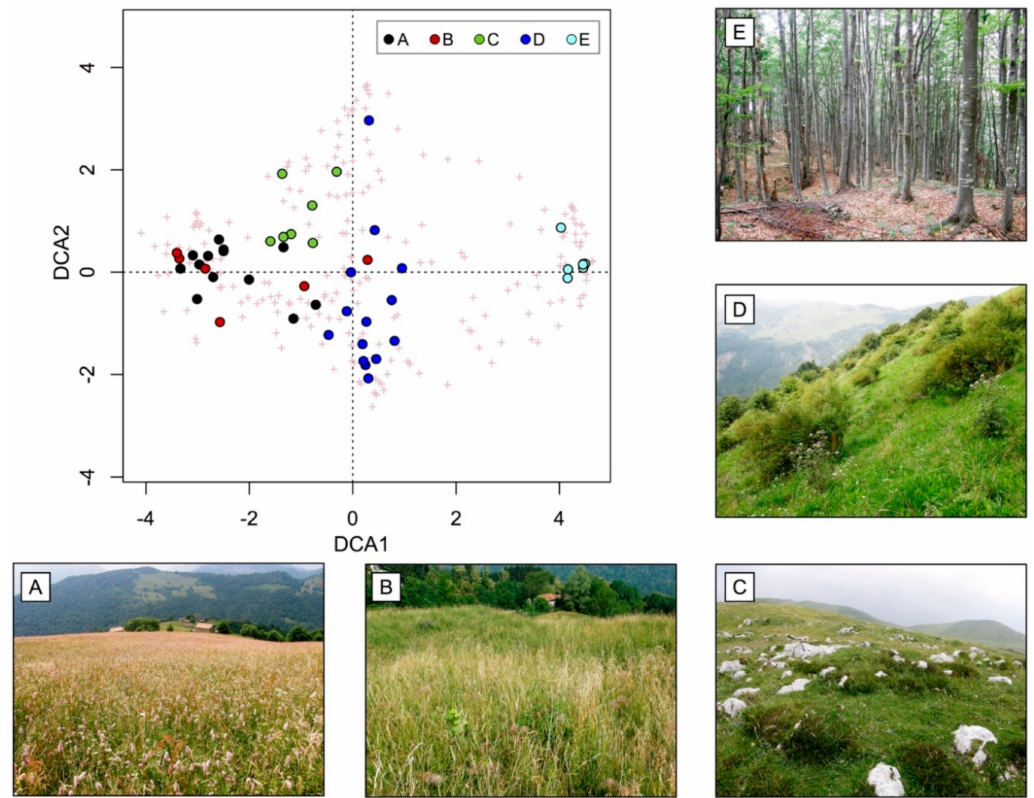
Figure 2. Detrended correspondence analysis (DCA) biplot of relev é s. Capital letters indicate the five types of vegetation: ( A ) meadows (number of species: 98); ( B ) meadows-pastures (number of species: 87); ( C ) pastures (number of species: 89); ( D ) shrublands (number of species: 173); ( E ) forests (number of species: 84). Eigenvalues for the first four axes of DCA are reported in Table